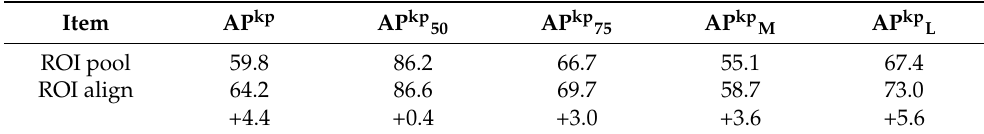
Table 1. Comparison of ROI pooling and ROI align [8].